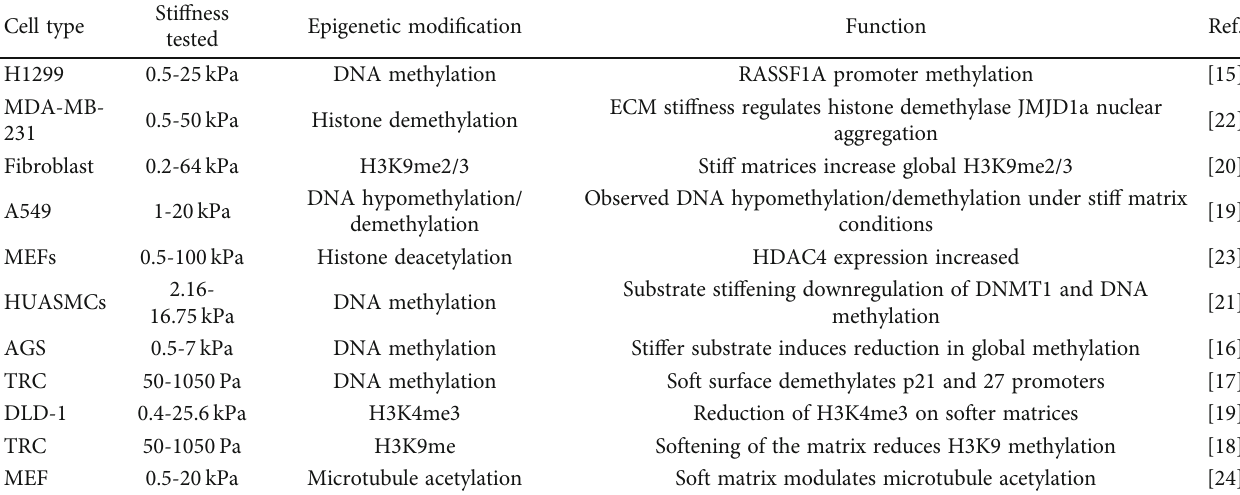
Table 1: Summary of the e ff ects of matrix sti ff ness on histone modi fi cations in cell